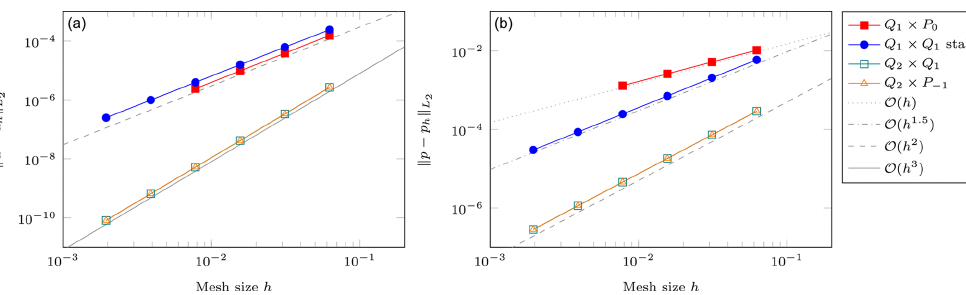
Figure 2. Donea and Huerta benchmark. Error convergence as a function of the mesh size h . (a) Velocity error || u − u h || L error || p − p h || L . The two leftmost points are missing for Q 1 × P 0 since the solver failed to converge; the data points for Q 2 × Q 1 and 2 Q 2 × P − 1 are on top of each